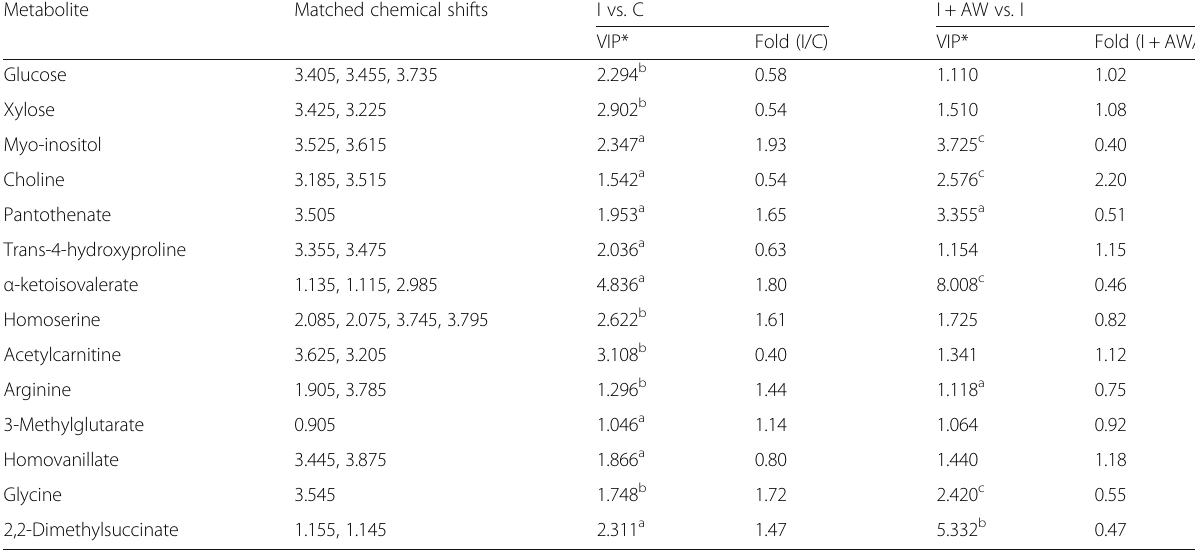
Table 3 Differentially expressed serum metabolites between normal controls and rats with gastric ulcer and between gastric ulcer and after treatment with AW extract Metabolite Matched chemical shifts